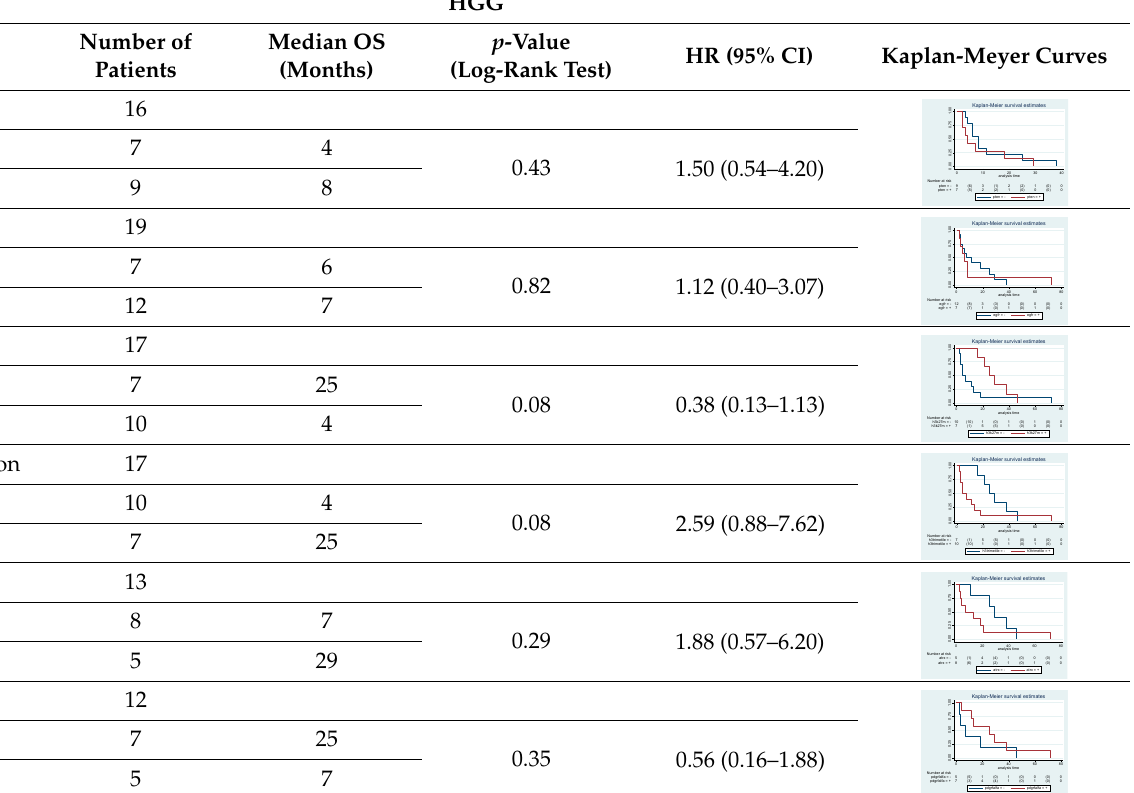
Abbreviations: CI, confidence interval; HR, hazard ratio; OS, overall survival. 4. Discussion Thalamic glial lesions are rare tumors, and their natural history and treatment are only infrequently touched by the neurosurgical literature. Since the thalamus is an im- portant eloquent area with crucial roles in both sensorimotor and superior functions [20], the current neurosurgical attitude is that the treatment must be highly tailored based on